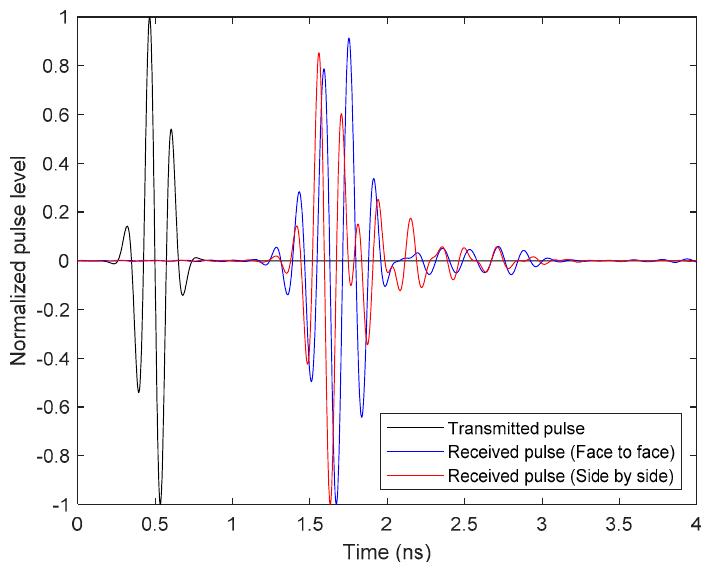
Figure 16. Transmitted and received broadband pulse for both configurations, face-to-face (blue line) and side-by-side (red line).